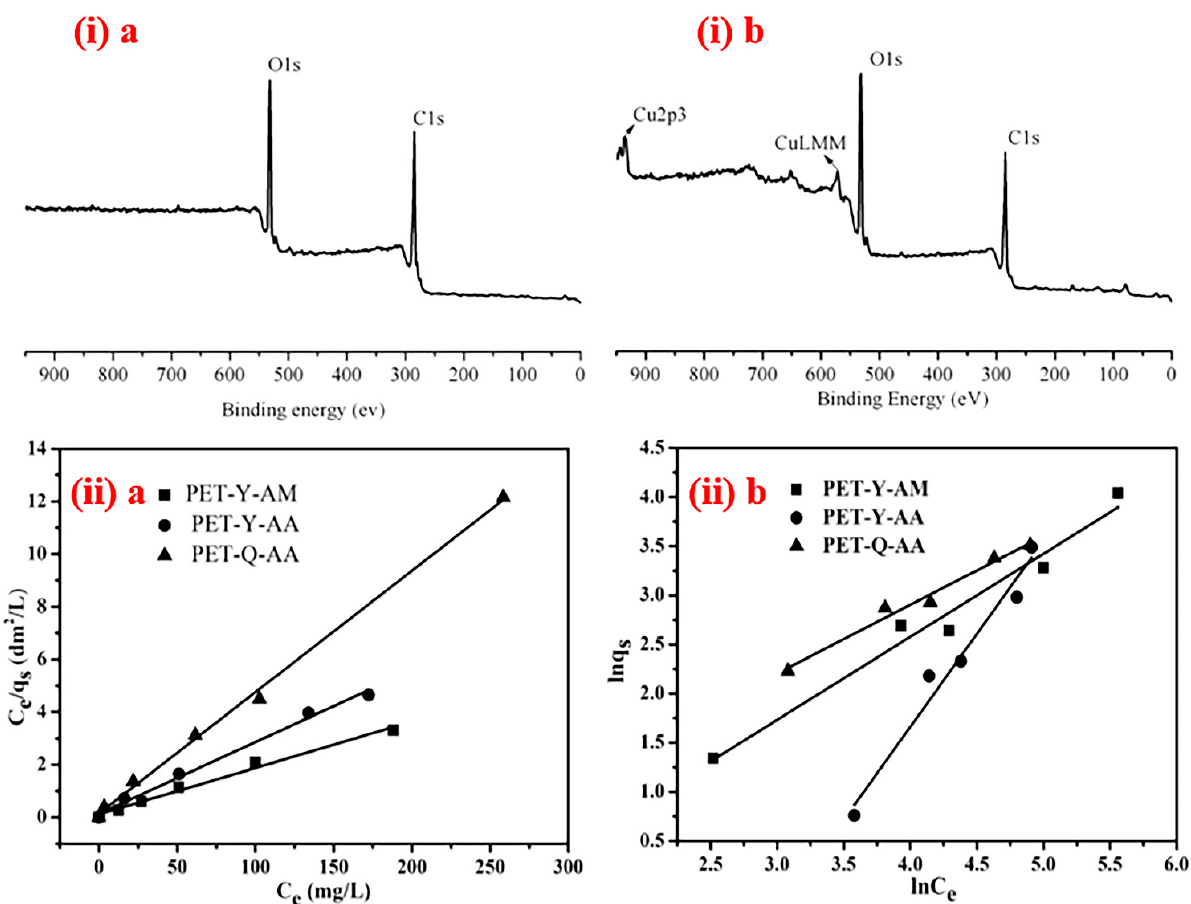
Figure 4. PET-AA nanofibrous membrane ( i ) XPS spectra a. before and b. after Cu 2+ adsorption, ( ii ) adsorption isotherms according to ( a ) Langmuir equation and ( b ) Freundlich equation [210], with permission from Elsevier, 2010.